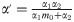
Theoretical prediction of the power spectrum density (PSD) (Eq (13)) for fluctutions of the total number of susceptible livestock, infected livestock and infected mosquitoes.(First Row) The theoretical prediction using the simplified force of infection. The values of the parameters used in years are as follows: q1 = 0.05, μ1 = (1/16) ∗ 360, μ2 = 1/8, β12 = 0.170, β21 = 0.116, ϵ2 = (1/4) ∗ 360, α′ = α = 256 and m0 = 1.5. This gives R0 = 1.0066. (Second Row) Comparison between theoretical predictions of PSD under the simplified and complex versions of the forces of infection. For the complex force of infection the new parameters are α1 = 0.33, α2 = 19, m0 = 9.45 and α′=α1α2α1m0+α2, and R0 = 1.0074. Note that description and sources of all model parameters are given in Table 1.